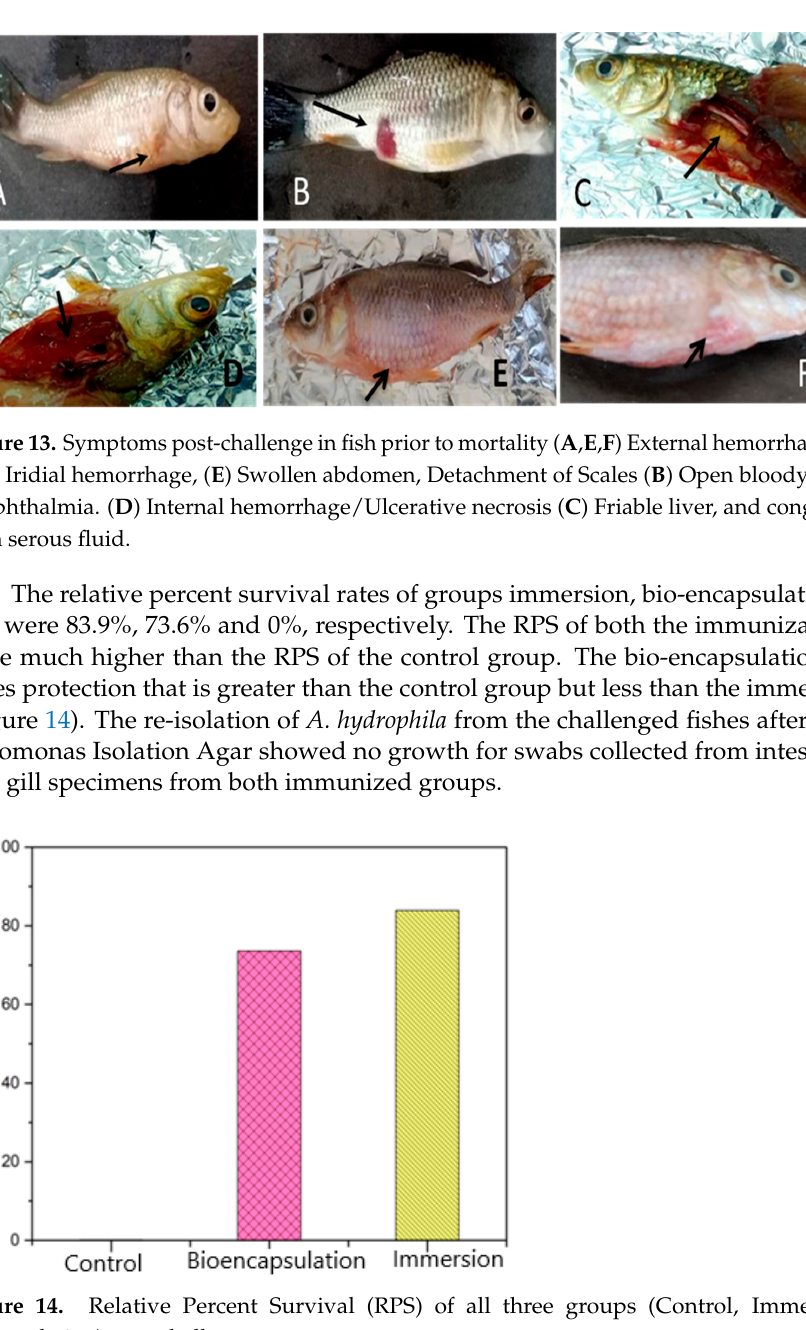
Figure 12. Cumulative mortality index (CMI) of all three groups (Control, Immersion and Bio-en- capsulated) postchallenge.